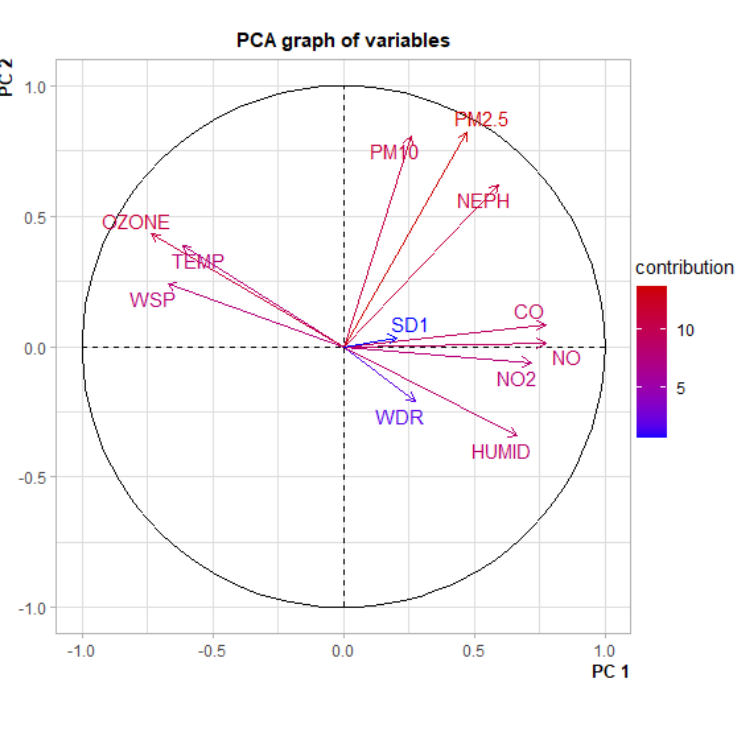
Figure 3. Principal Component Analysis plot of variables.